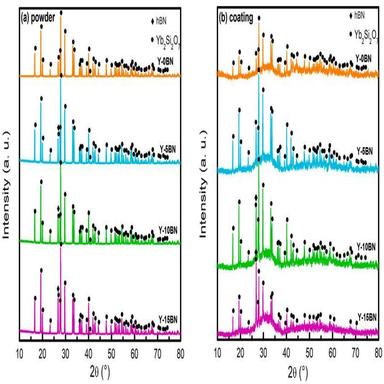
XRD patterns of feedstock powders (a) and coatings (b).